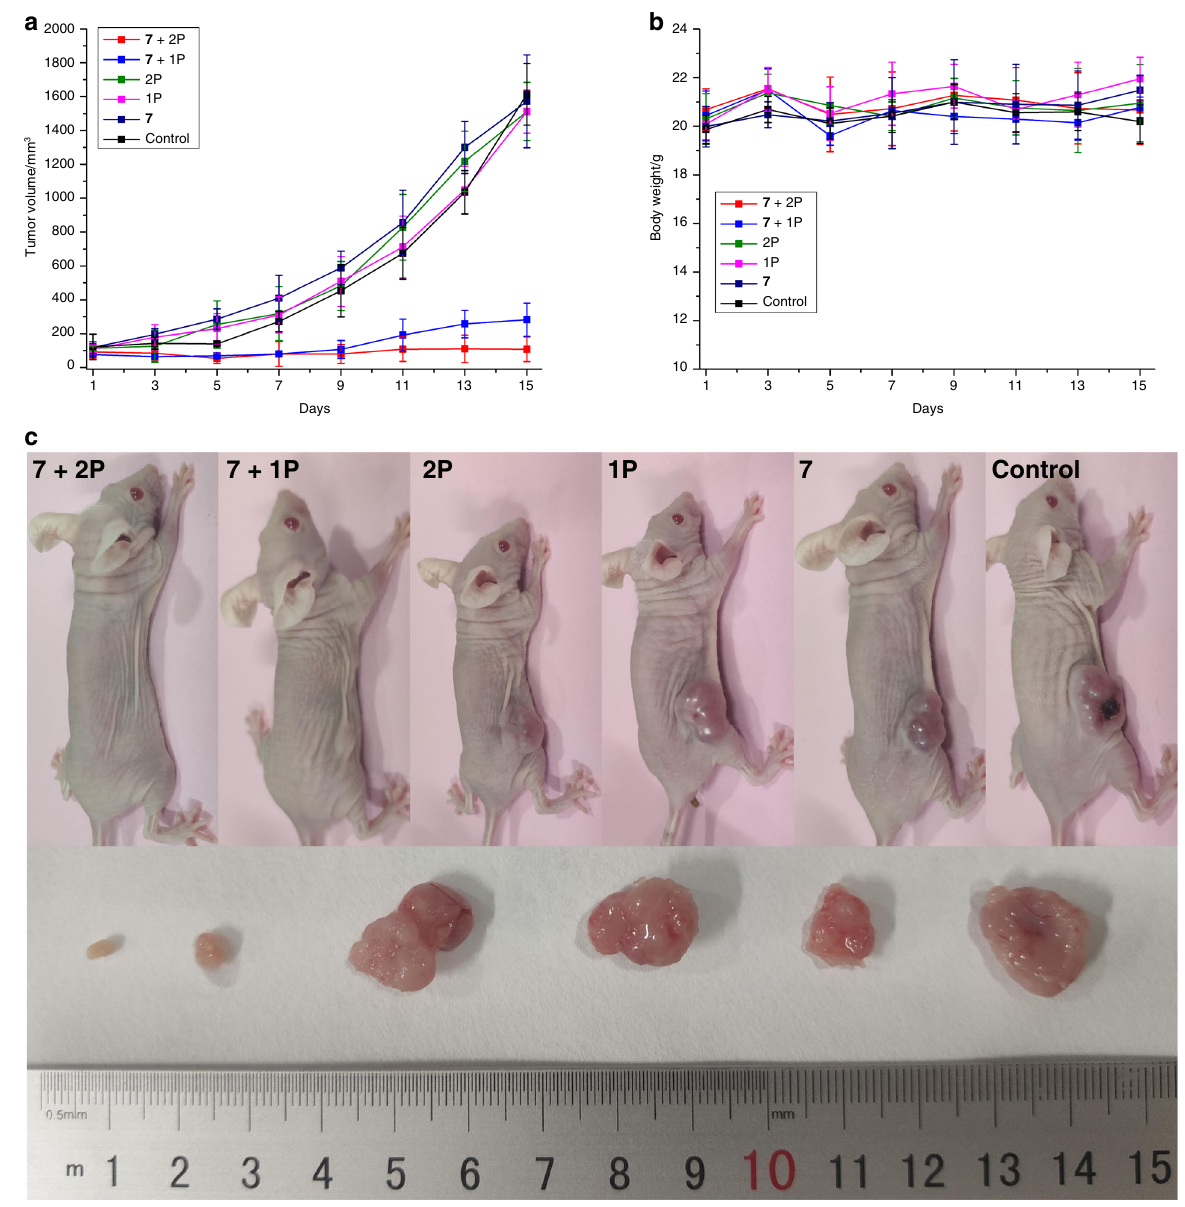
Fig. 5 Biological Evaluation of 7 inside a mouse model. In vivo PDT study of 7 using 1P (500 nm, 60 min, 10.0 mWcm − 2 , and 36 J cm − 2 ) or 2P (800 nm, 50 mW, 1 kHz, pulse width 35 fs, and 5 s mm − 1 ) excitation on nude mice bearing a doxorubicin-selected P-gp-overexpressing human colon cancer tumor (SW620/AD300). a Tumor growth inhibition curves upon treatment. b Average body weights of the tumor-bearing mice. c Representative photographs of the tumor-bearing mice. The error bars correspond to the standard deviation of the fi ve